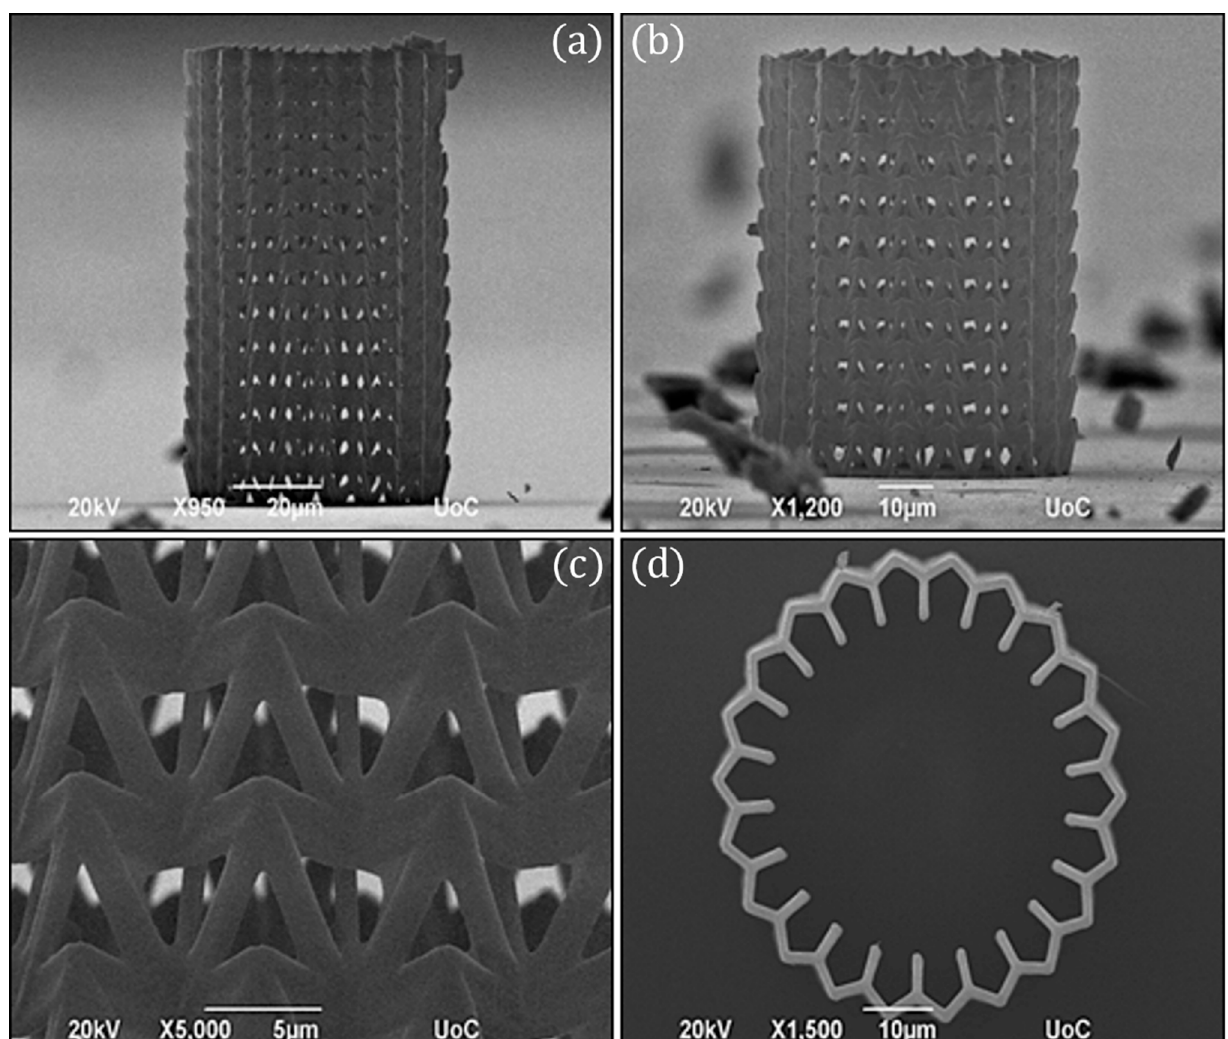
Figure 4. SEM images of the auxetic stent comprised of the re-entrant triangular fabricated using Nano-cube at 90 mJ/cm 2 laser fluence and 100 μ m/s scan speed. ( a ) Side view of ~90 nm in height stent, ( b ) Side view of ~60 nm in height stent, ( c ) Close view of the lattice, and ( d ) Top view.